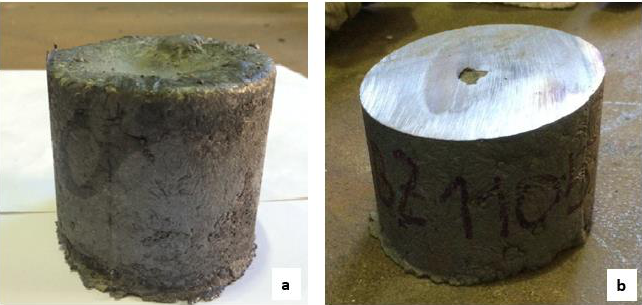
Figure 7. ( a ) initial NbNi sample, ( b ) NbNi alloy in the graphite crucible and ( c ) Ti “sponge”. After the VIM process, the Ni 33 Ti 39 Nb 28 ingot, with a diameter of 80 mm, was removed from the crucible. Figure 8 shows the ingot before and after cutting; its final measured composition is reported in Table 2.